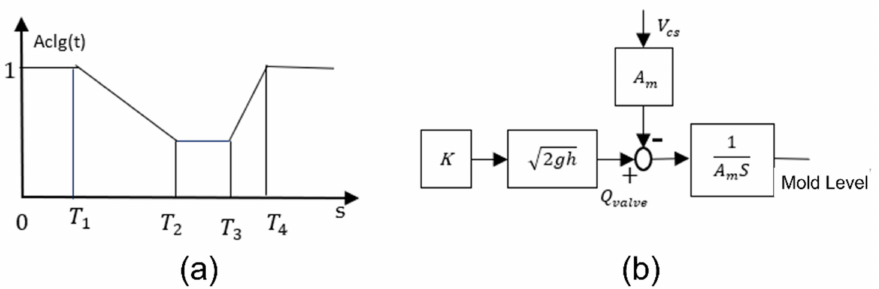
Figure 6. ( a ) Graphic representation of the clogging/unclogging rate of the gate valve area; ( b ) block diagram with the inclusion of the clogging effect.